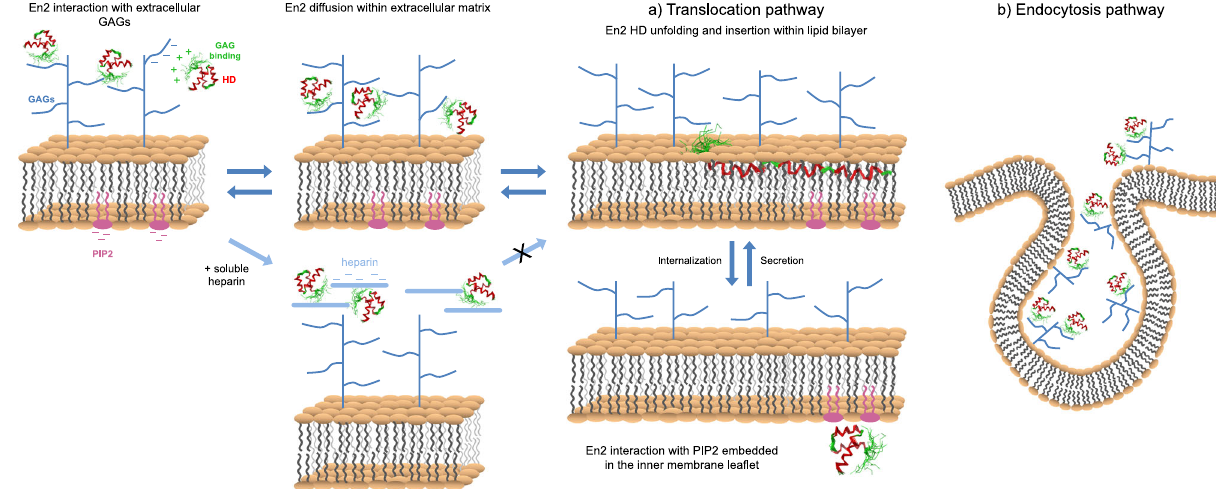
Fig.5|HypotheticalmodelofGAG-dependentbidirectionaltransfertofHPsacrosstheplasmamembrane. TheroleofhighlysulfatedHSincellinternalizationofEn2 through translocation and endocytosis pathways is illustrated in panels a and b ,